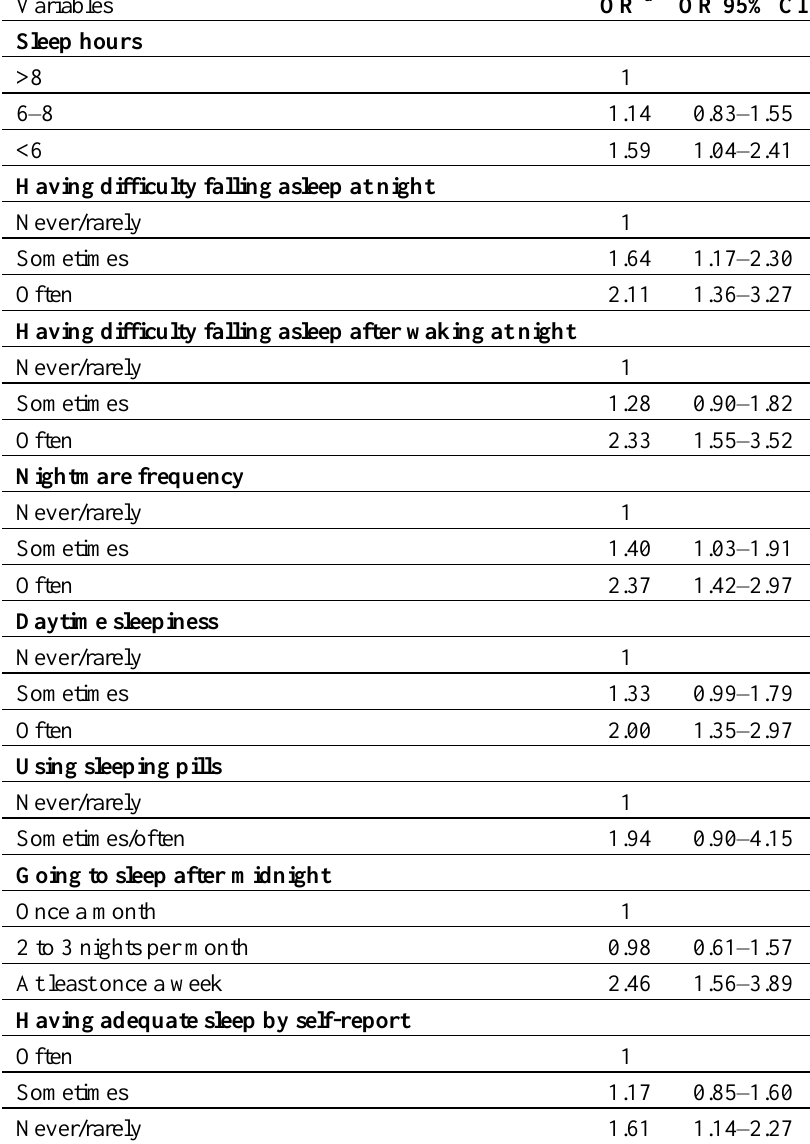
Table 5. Eight logistic regression analyses of association between each sleep-related variable and agricultural work-related injury in farmers in